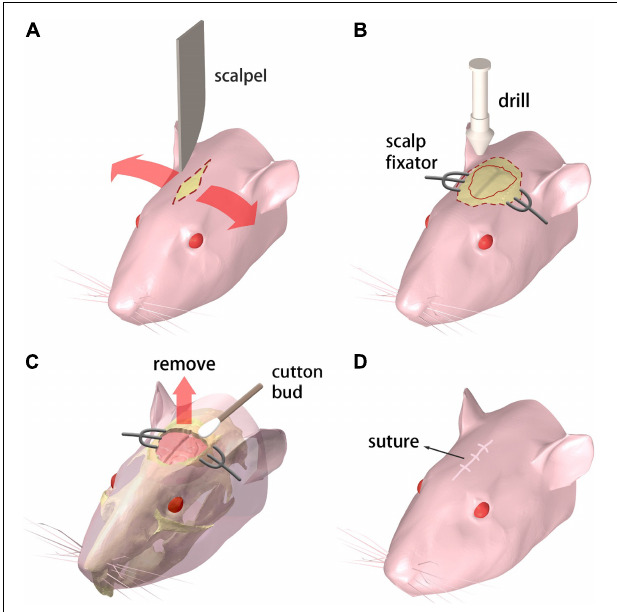
FIGURE 1 | Procedure for creating the chronic cranial window. (A–D) Step 1 through 4, respectively. Refer to text for